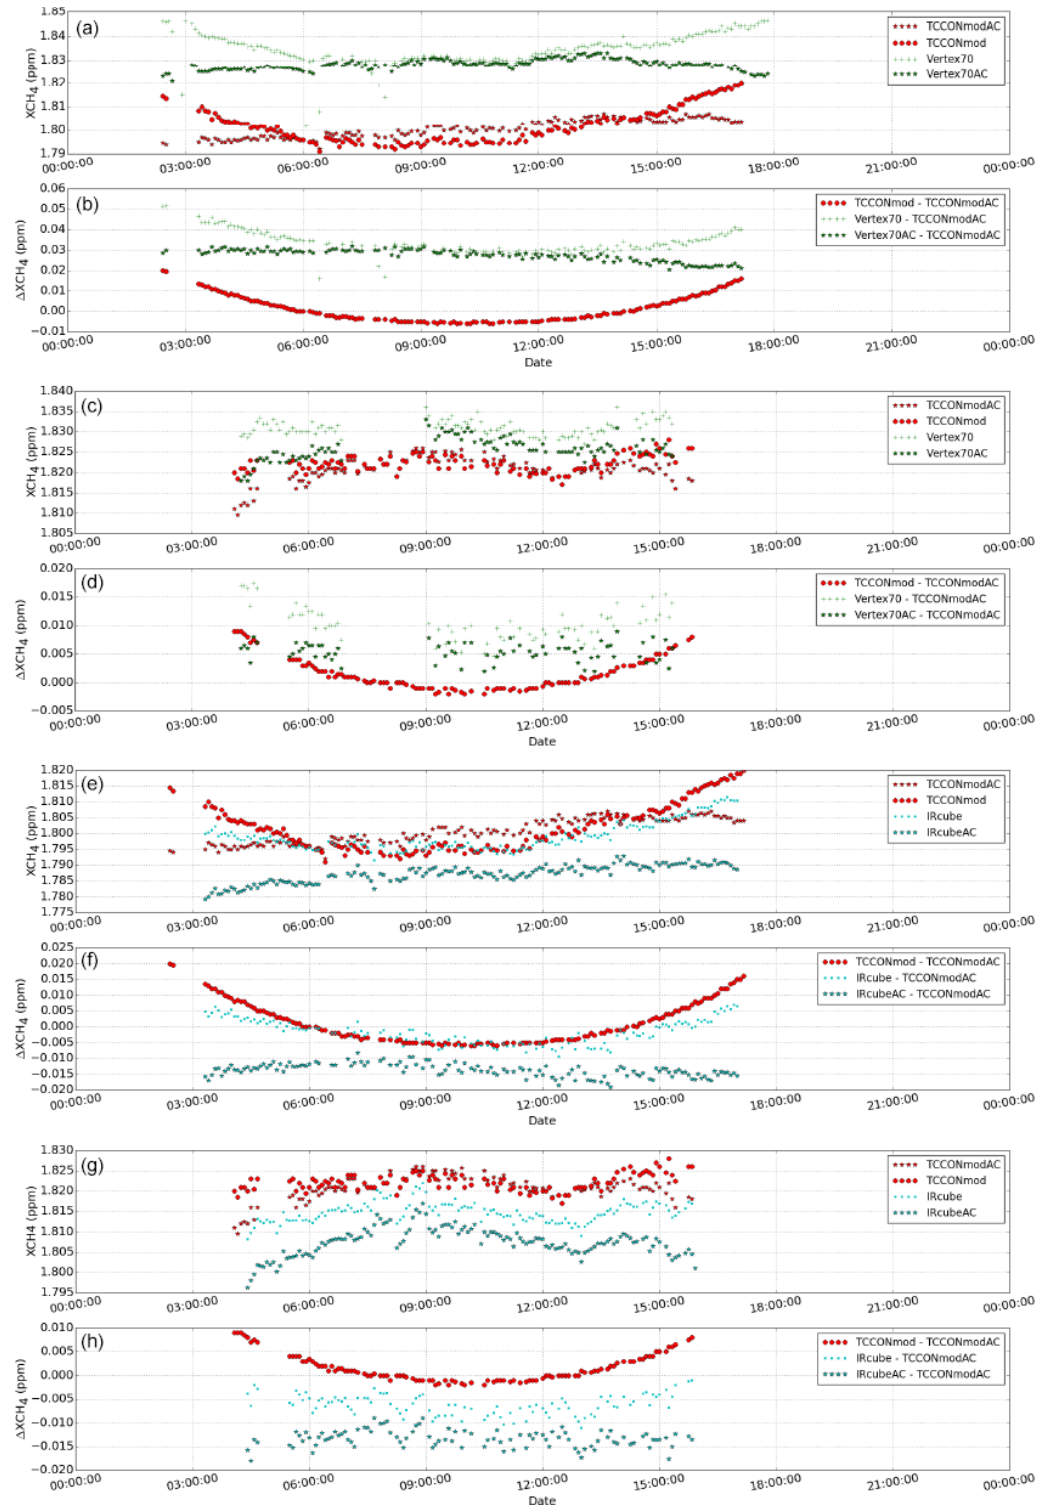
Figure A5. XCH 4 values plotted for TCCONmod and Vertex70 retrievals with the TCCON a priori and with a modified a priori (calculated using in situ, AirCore, and TCCON map files; labelled with AC at the end) are shown in panel (a) , and their difference is shown in panel (b) for measurements performed on 15 May 2017 at Sodankylä. Panels (c) and (d) show the same plots for 28 August 2017. The same plots for TCCONmod and IRcube retrievals for measurements performed on 15 May 2017 are shown in panels (e) and (f) , and those for 28 August 2017 are shown in panels (g) and (h)